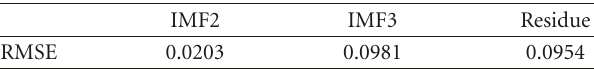
Table 3: RMSE of proposed